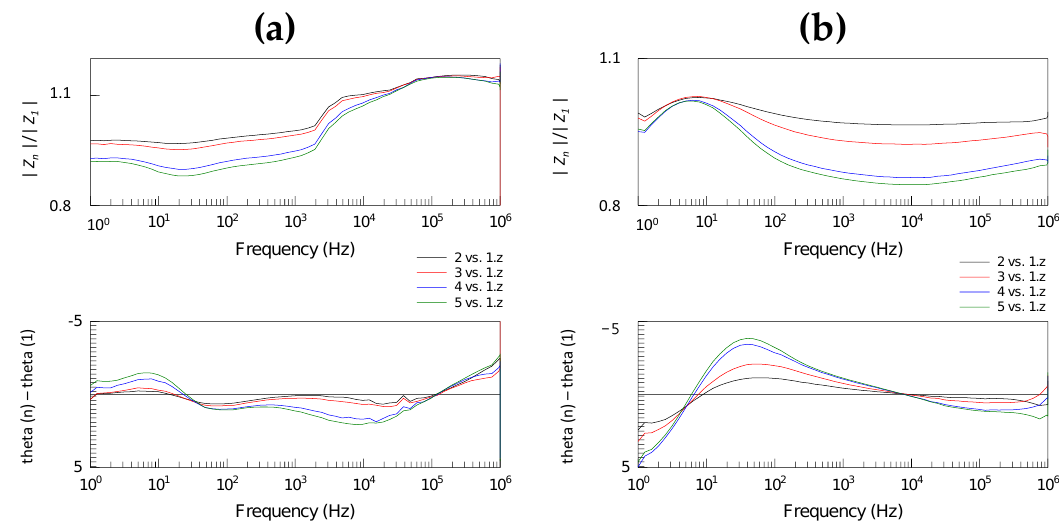
Figure 5. The complex division of BIS spectra for the same ( a ) cucumber and ( b ) tongue sample using the outer with grounding configuration shows the clear time-variant nature of the measurements. A total of five repeated scans were performed, and here the subsequent measurement is compared to the first one.